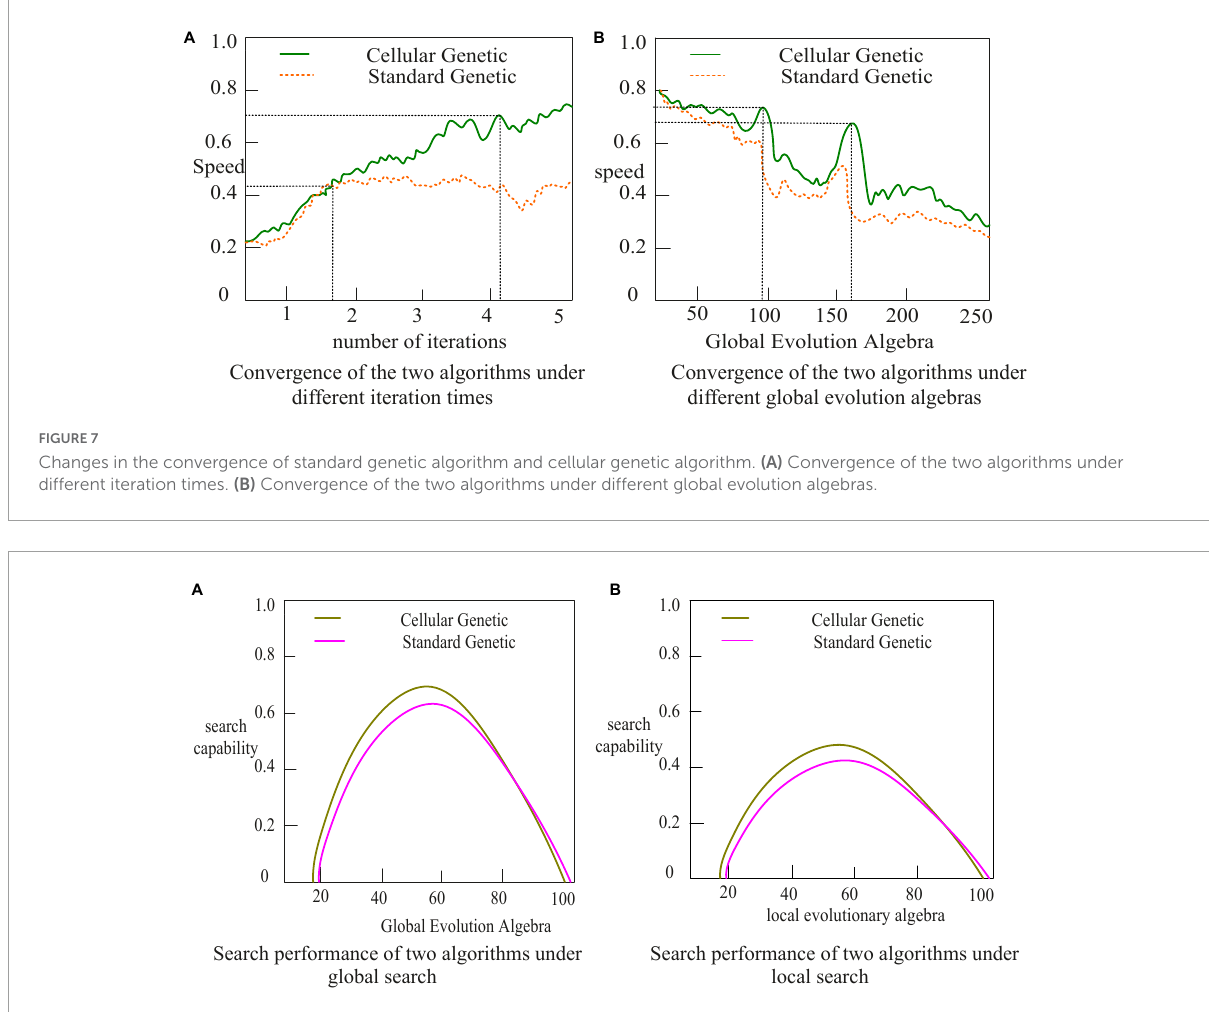
FIGURE8 Comparison of search performance between standard genetic algorithm and cellular genetic algorithm. (A) Search performance of two algorithms under global search. (B) Search performance of two algorithms under local